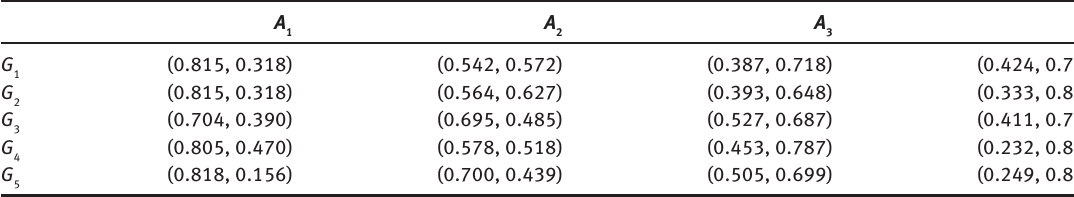
Table 10: Pythagorean Fuzzy Hybrid Decision Matrix.